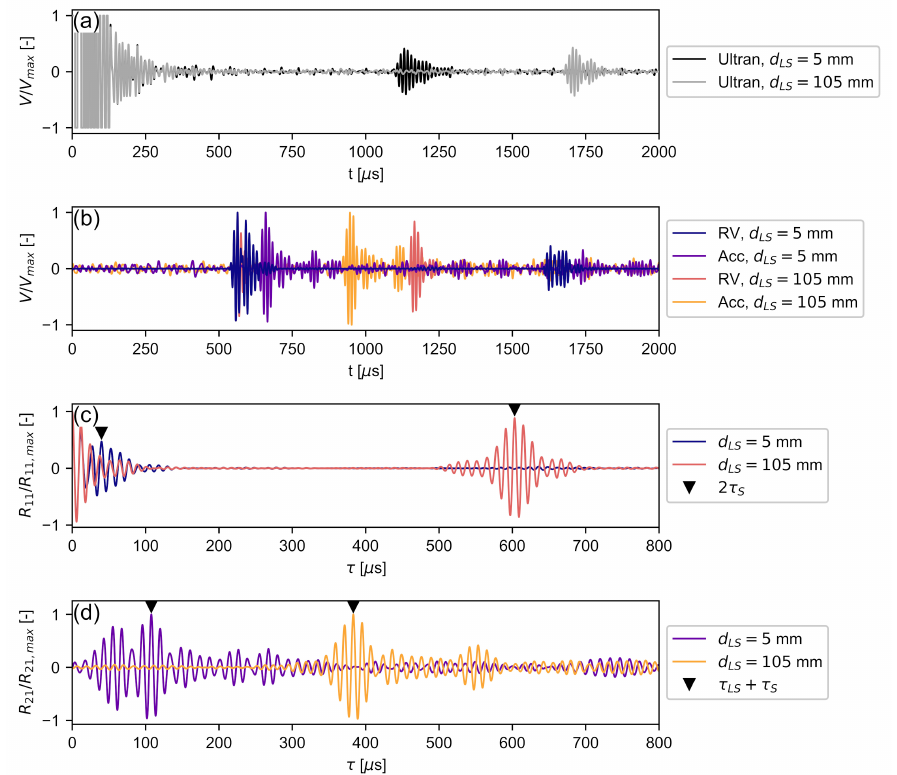
Figure 8. Measurement procedure for d TL = 180 mm and two different d LS : ( a ) shows the time signal from the Ultran piezo transducer as a reference; ( b ) shows the RV and accelerometer time signals; ( c ) shows the autocorrelation results of the RV signals; ( d ) shows the cross-correlation results of the RV and accelerometer